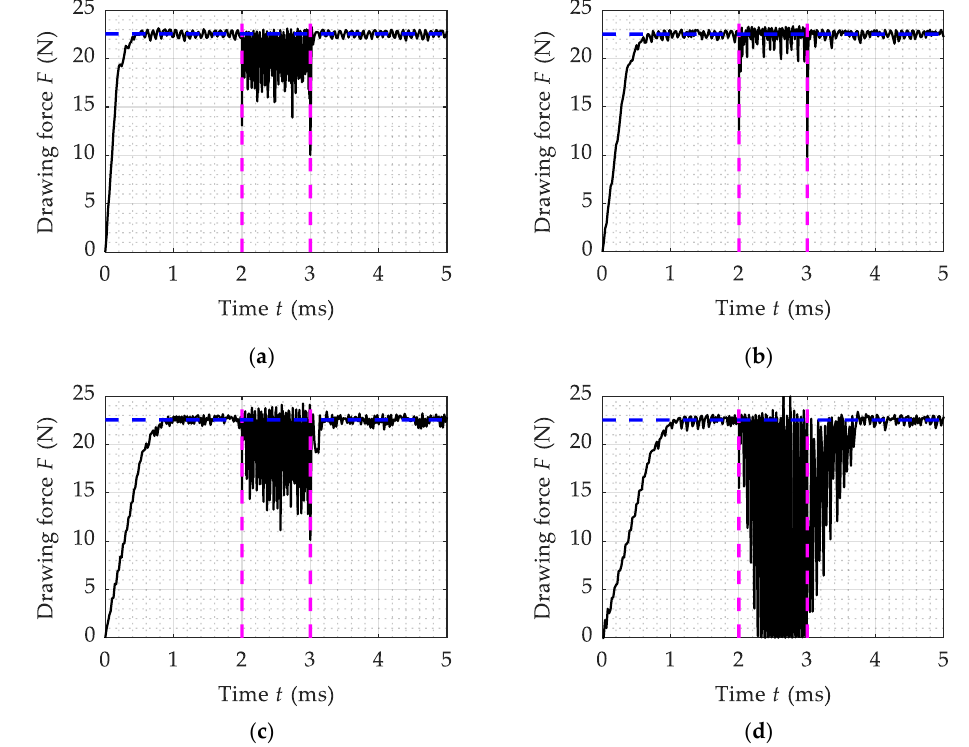
Figure 3. Time-variation of the drawing force for different distances between the die and the reel: ( a ) L = 31.6 mm; ( b ) L = 63.2 mm; ( c ) L = 94.8 mm; ( d ) L = 126.4 mm. ( a ) L = 31.6 mm; ( b ) L = 63.2 mm; ( c ) L = 94.8 mm; ( d ) L = 126.4